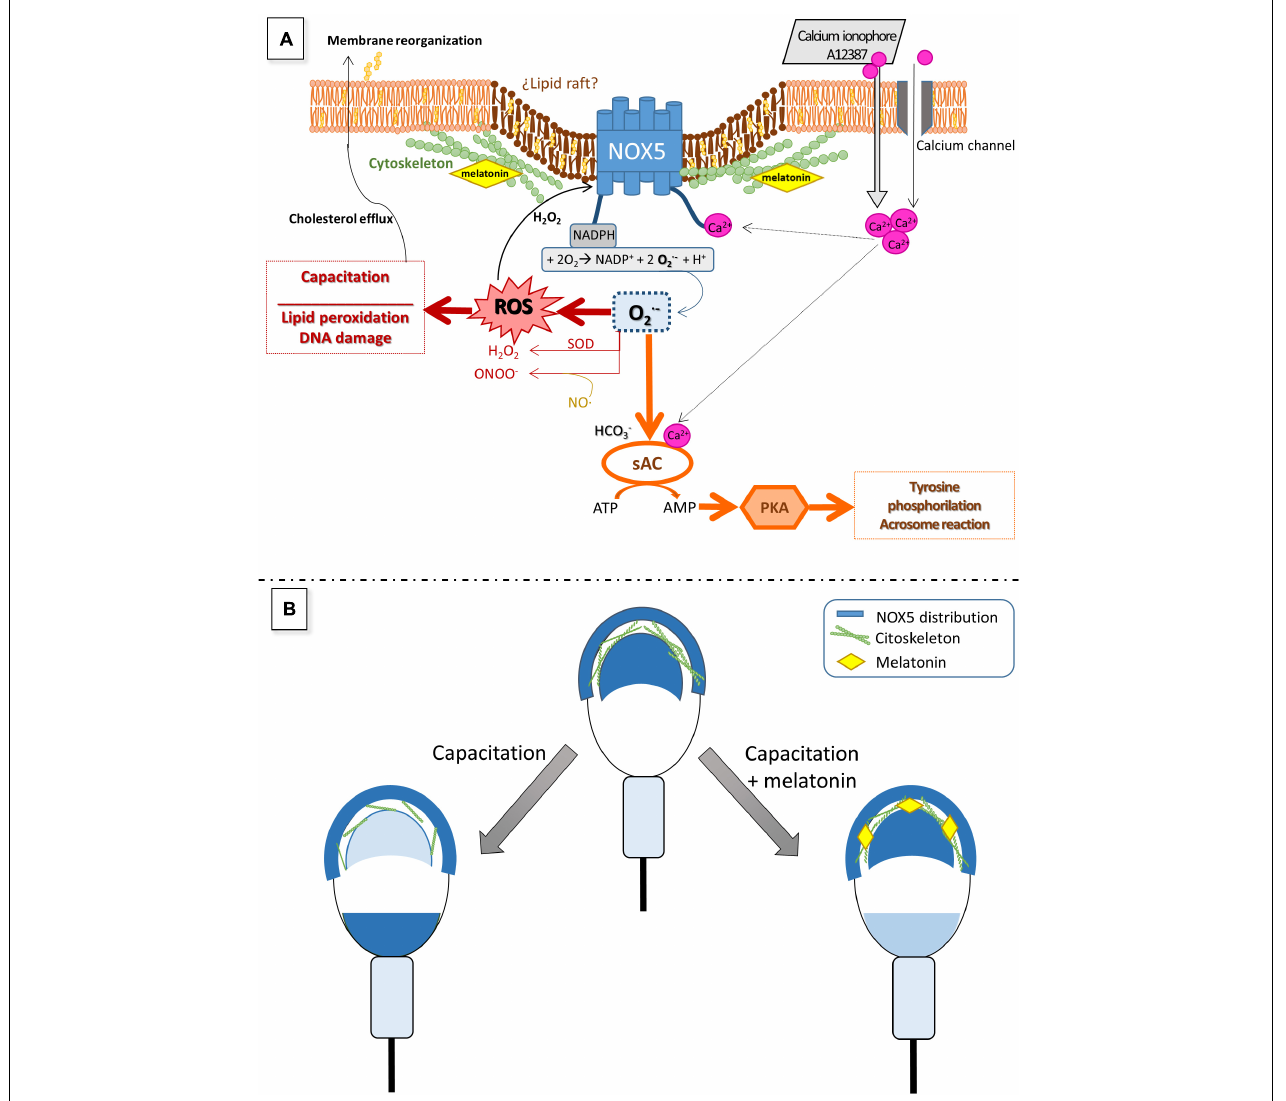
FIGURE 10 | Hypothetical model to explain the role of NOX5 in ram spermatozoa (A) and changes in its localization during sperm capacitation (B) , as well as the putative effect of melatonin on NOX5 (A,B) . Calcium entry from the extracellular media through multiple calcium channels in sperm membrane directly activates NOX5 throughout the N-terminal calcium-binding domains. NOX5 activation generates superoxide which quickly dismutates in H 2 O 2 and other ROS that take part in numerous signaling pathways, including capacitation processes and NOX5 reactivation. Lewis and Aitken (2001) also proposed that superoxides, together with bicarbonate and calcium, can activate a soluble adenyl cyclase (sAC) which produces cAMP leading to the activation of protein kinase A (PKA). PKA provokes an increase in tyrosine phosphorylation, a crucial event for the ongoing of the capacitation process. The findings of the present work showing that the NOX inhibitor, GKT136901, is able to reduce the rate of ram-capacitated spermatozoa, will support this postulated mechanism. Regarding NOX5 localization, mainly in the acrosome region and the apical edge, we have demonstrated that it changes during ram sperm capacitation. To explain this redistribution we could hypothesize that NOX5 could be embedded in lipid rafts, as it has been demonstrated in somatic cells (Anagnostopoulou et al., 2020). During the capacitation process, the cholesterol efflux from the sperm membrane allows the reorganization of the lipid rafts (van Gestel et al., 2005), giving new protein distributions, and modulating